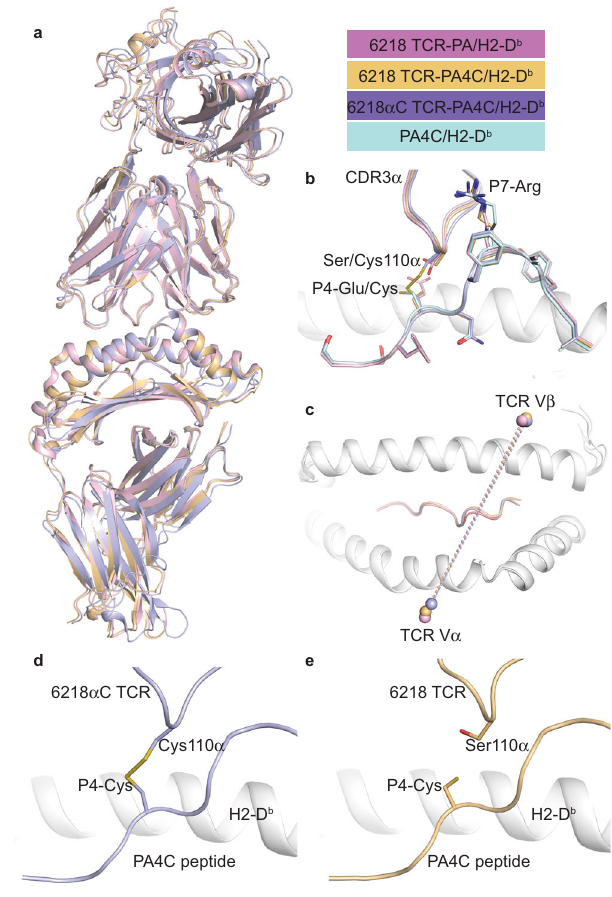
Fig. 5 | TCR-peptide S-S bonding without structural rearrangement. a Superposition of the three TCR-pMHC structures solved in this study with the 6218 TCR-PA/H2-D b complex in pink, the 6218 TCR-PA4C/H2-D b in gold, and the 6218 α CTCR-PA4C/H2-D b inpurple. b Zoom-inviewontheTCR-peptideinterfacein a with the addition of the PA4C/H2-D b structure(PA4Cpeptide in pale blue). c Top view of the H2-D b antigen-binding cleft in white cartoon with the mass centre (sphere) of each TCR variable domain from the three TCR-pMHC structures (color codingasin a ). d Structureofthe6218 α CTCR(purple)incomplexwithPA4C/H2-D b (peptide in purple, MHC in white) showing a S-S bond formed at the interface. e Structure of the 6218 TCR (gold) in complex with PA4C peptide (gold) presented by H2-D b (white). See Supplementary Fig. 7 for electron density maps and further comparison of PA/H2-D b and PA4C/H2-D b